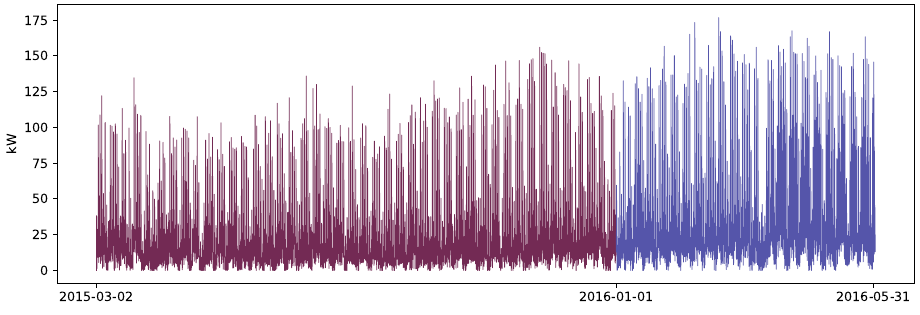
( a ) Complete time series showing the evolution of electric vehicle (EV) power consumption from March 2015 to end of May 2016.